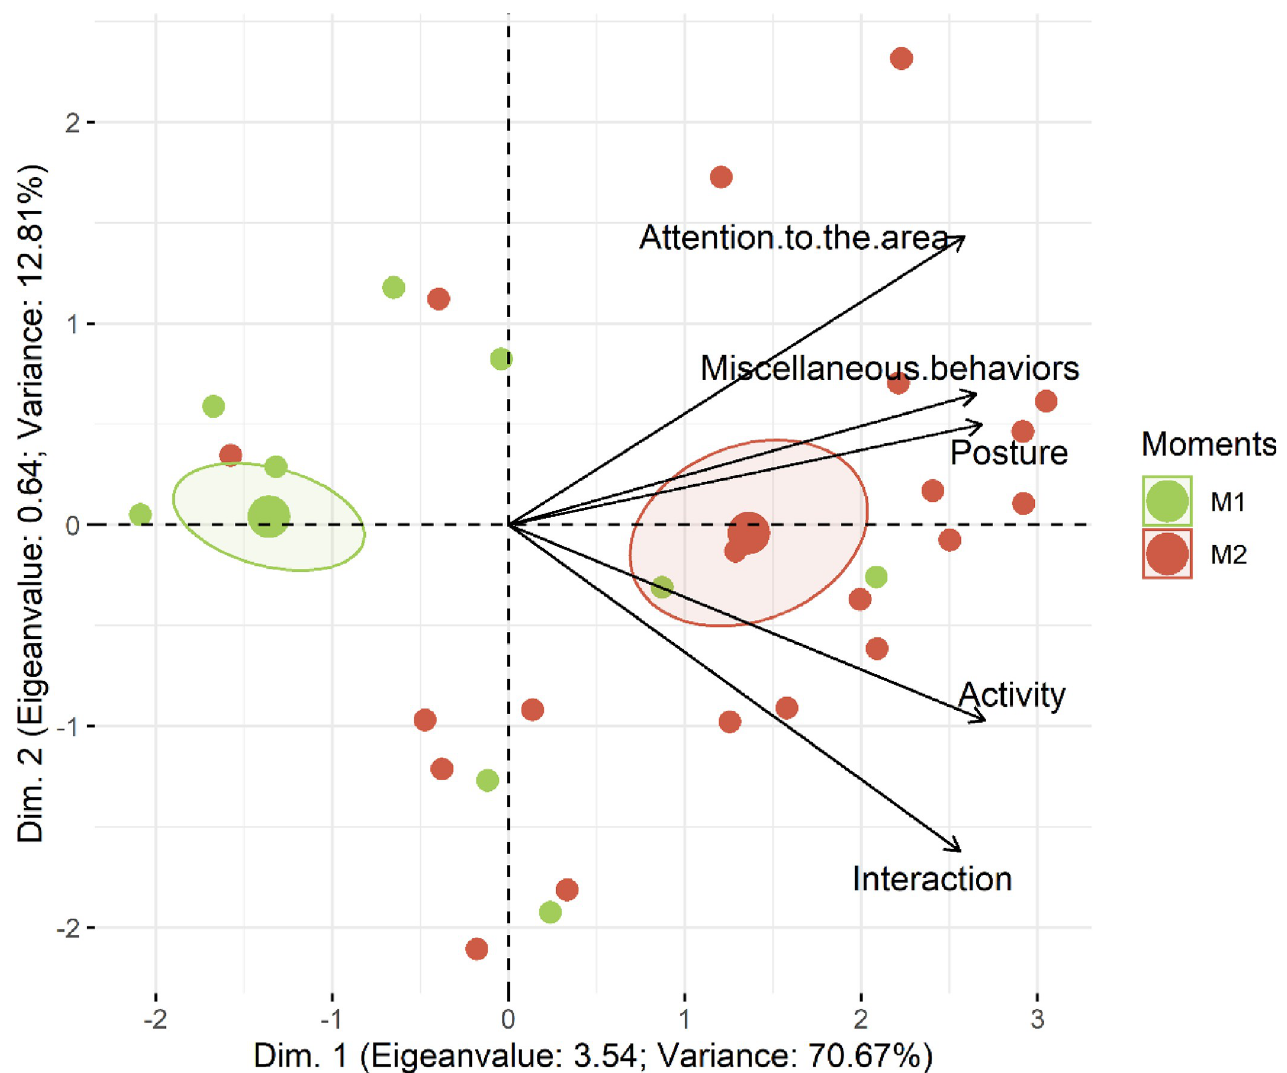
Fig 6. Biplot of the principal component analysis of the UPAPS items applied to awake piglets (n = 14 castrated piglets). UPAPS–Unesp-Botucatu pig acute composite pain scale. Confidence ellipses indicate perioperative moments and pain scores. Moments: M1 (24h pre-procedure), M2 (15-min post- procedure, before rescue analgesia). Ellipses were constructed according to the assessment. Each circle corresponds to the score from one observer attributed to each piglet at each moment.